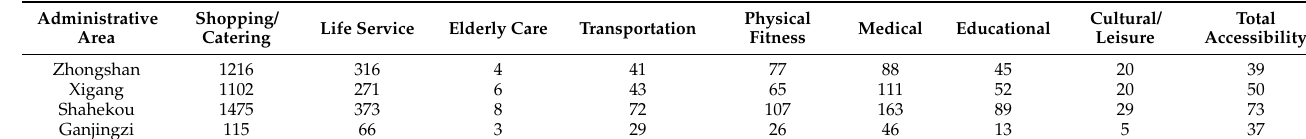
Table 3. Mean public service facility accessibility of the central urban area in Dalian.